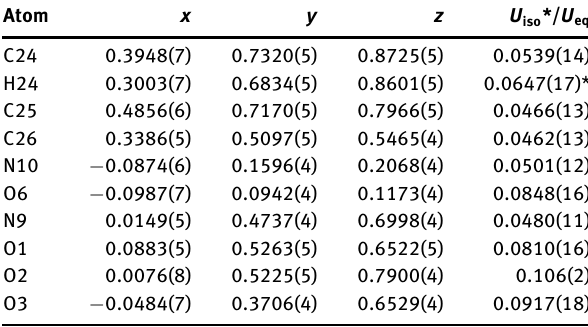
Table 2: Fractional atomic coordinates and isotropic or equivalent isotropic displacement parameters (Å 2